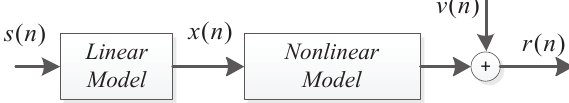
Figure 7. The structure of the nonlinear channel.